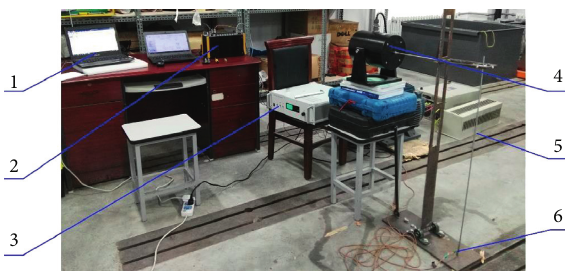
Figure 3: Diagram of the experiment system. 1, computer; 2, data